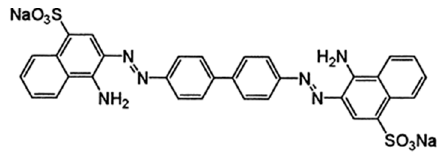
Figure 1. Structural formula of Congo Red.